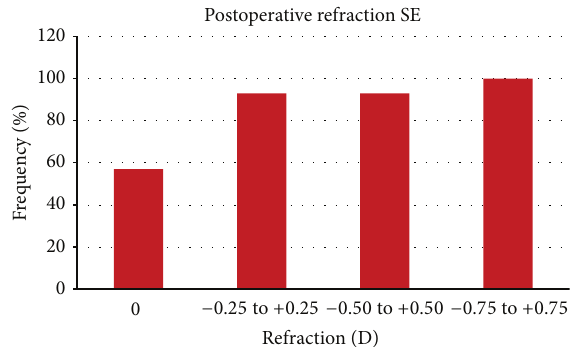
Figure 1: Distribution of the postoperative spherical equivalent (SE) at 3 months after surgery in the analysed sample.